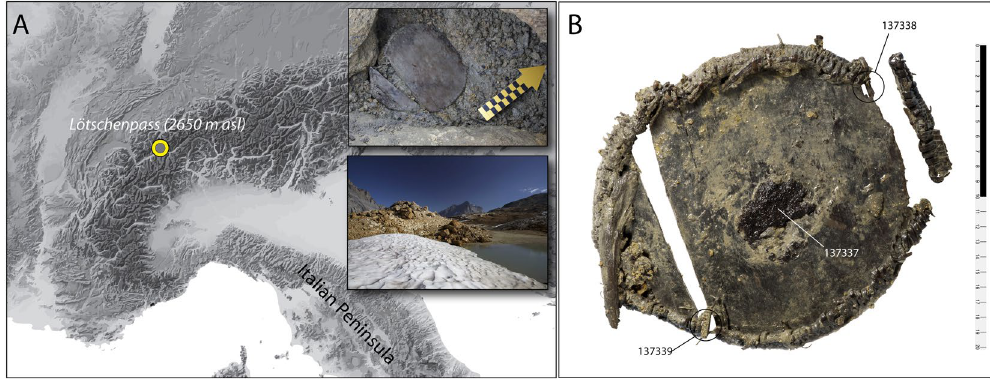
Figure 1. ( A ) geographic and local position of the artefact at the summit of the Lötschenpass (2650 masl); ( B ) the artefact showing the areas sampled for lipid and protein analysis. The map was generated using adobe illustrator CS on an acquired map (Custom map of the Alps from Map resources ® ). The photos were taken by Rolf Wenger, Marcel Cornelissen and Badri Redha ( Archaeological Service of the Canton of Bern ). The copyright holders gave permission to publish the images under Open Access licence (print and